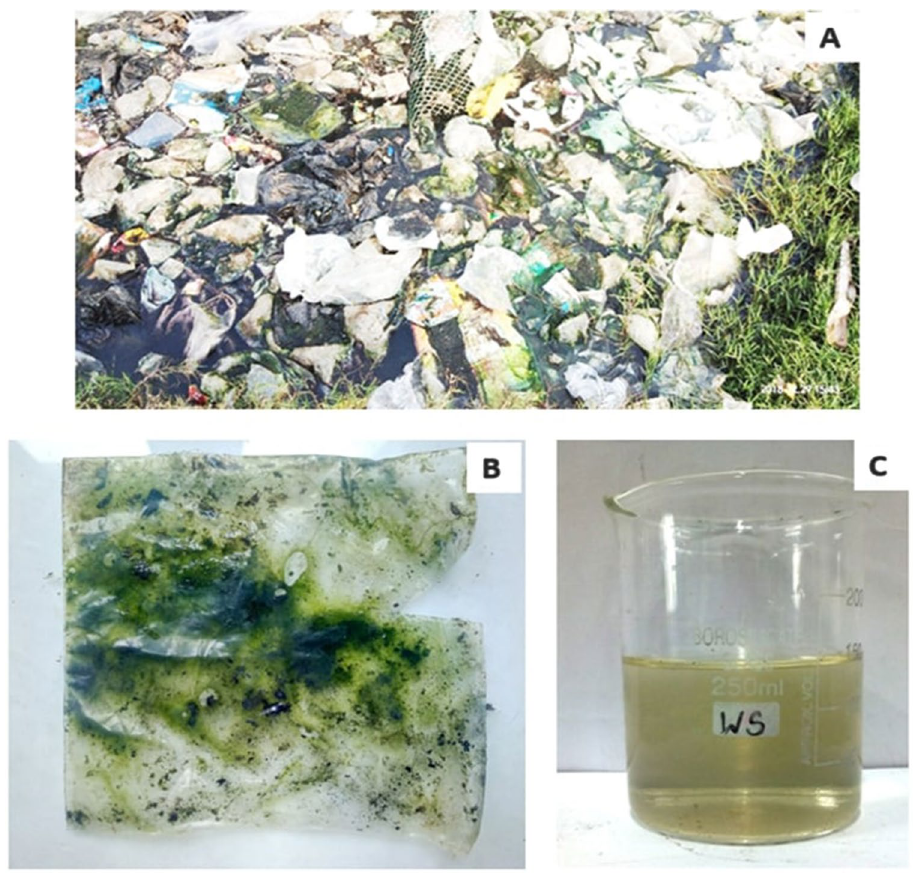
Figure 2. ( A ) The sampling site showing dumped waste plastic carry bags and other wastes; ( B ) Dumped waste plastic sheet found colonized by microalgae; ( C ) Water sample collected from the sampling